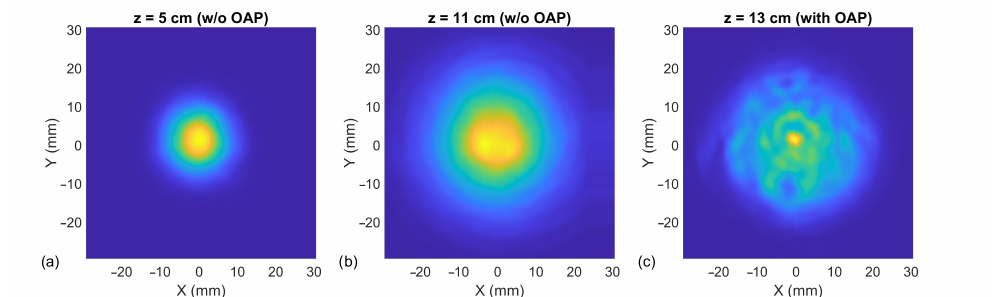
Figure 2. VDI source beam profile in X and Y direction at different distance z between the source and the detector at 252 GHz. Two different measurement setups were used: without additional optics (( a , b ) panels) and with one off-axis parabolic mirror (( c ) panel). The last one corresponds to Figure